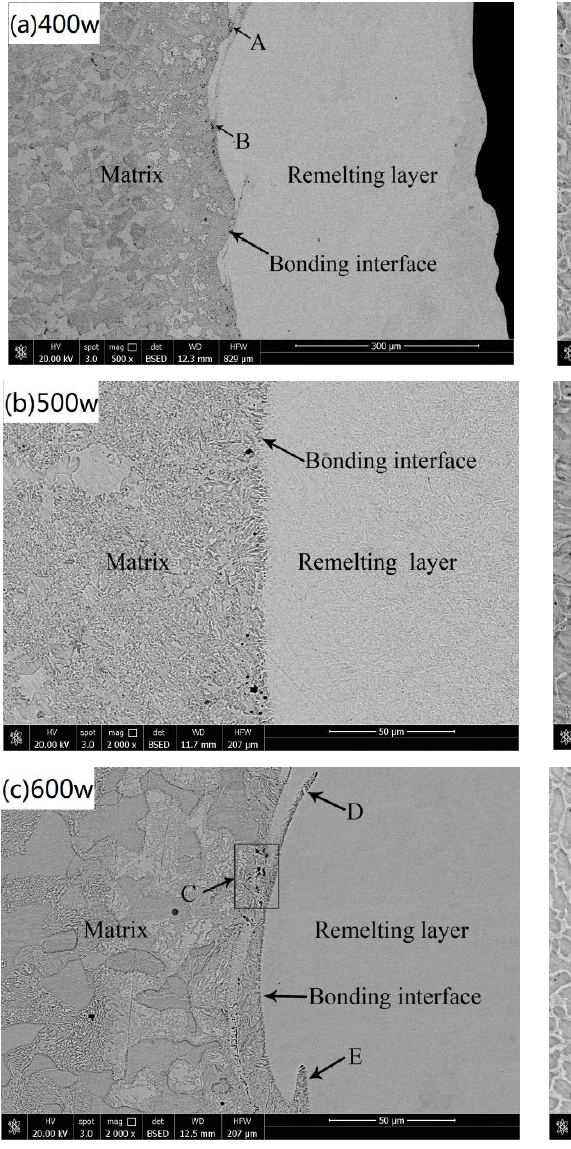
Figure 2. Interface morphology and cross section coating morphology under different powers: ( a ) 400 W; ( b ) 500 W; and ( c ) 600 W.